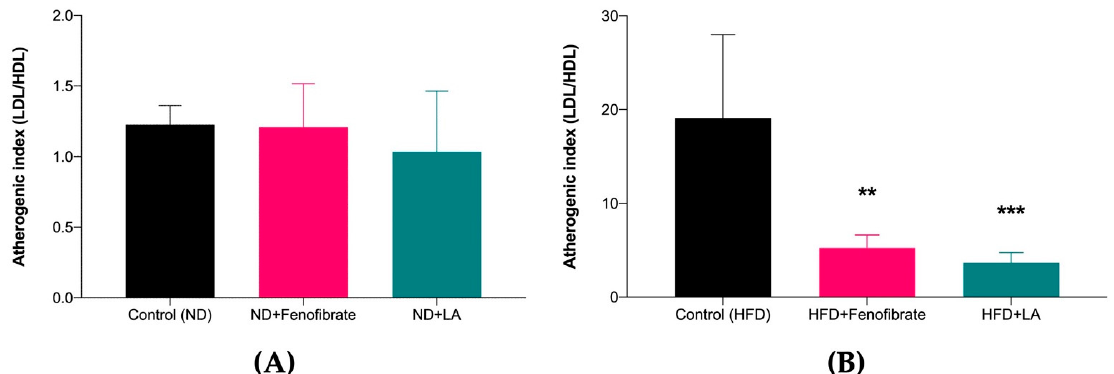
Figure 2. Atherogenic index of rats fed with normal diet ( A ) and high-fat diet ( B ) treated with linoleic acid (5 mg/kg) and fenofibrate (60 mg/kg) for 28 days. Data are presented as mean ± SD ( n = 6). ** p < 0.01, *** p < 0.001 vs. Control (HFD). Normal diet: ND; high-fat diet: HFD; linoleic acid: LA; low-density lipoprotein: LDL; high-density lipoprotein: HDL.